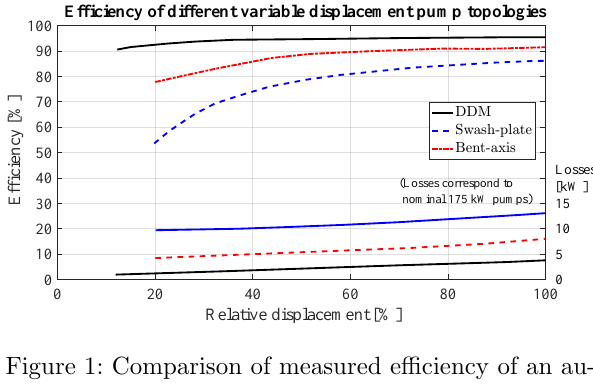
Figure 1: Comparison of measured efficiency of an au- tomotive scale 175 kW DDM against the more developed Bent-axis and Swash-plate variable displacement type pump topologies, based on graphs published in Taylor et al. (2011). The revolution speed is 1500